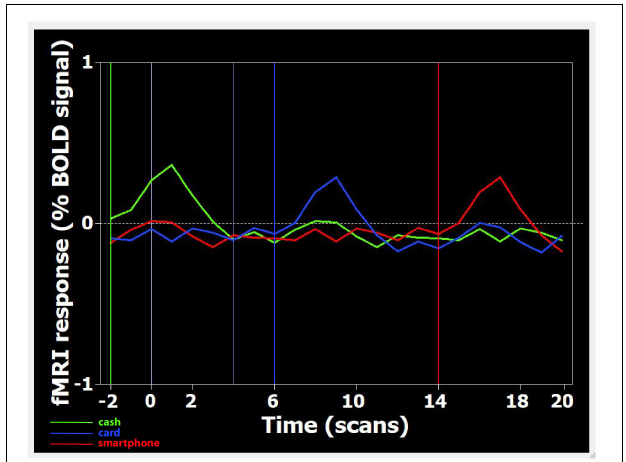
FIGURE 1 | Time course of BOLD signal changes in the parietal area, during the presentation of one Cash-Rest-Card-Rest-Smartphone stimulus sequence in a time window of 60 s. On the X -axis, the different digits refer to the number of acquired volumes (1 volume = 3 s). The BOLD signal change is plotted starting from two volumes (i.e., 6 s) before the first stimulation period up to 20 volumes (60 s) after. Since during functional run processing the first 2 volumes are skipped (see section “Materials and Methods”), video onset is actually at –2 volumes (i.e., 6 s before 0). Each colored curved line represents the average BOLD signal change detected, in the whole sample, during the visualization of Cash (green), Card (blue), and Smartphone (red) payment of 150 Euro. Each colored vertical line indicates the onset of footage displaying the relative payment